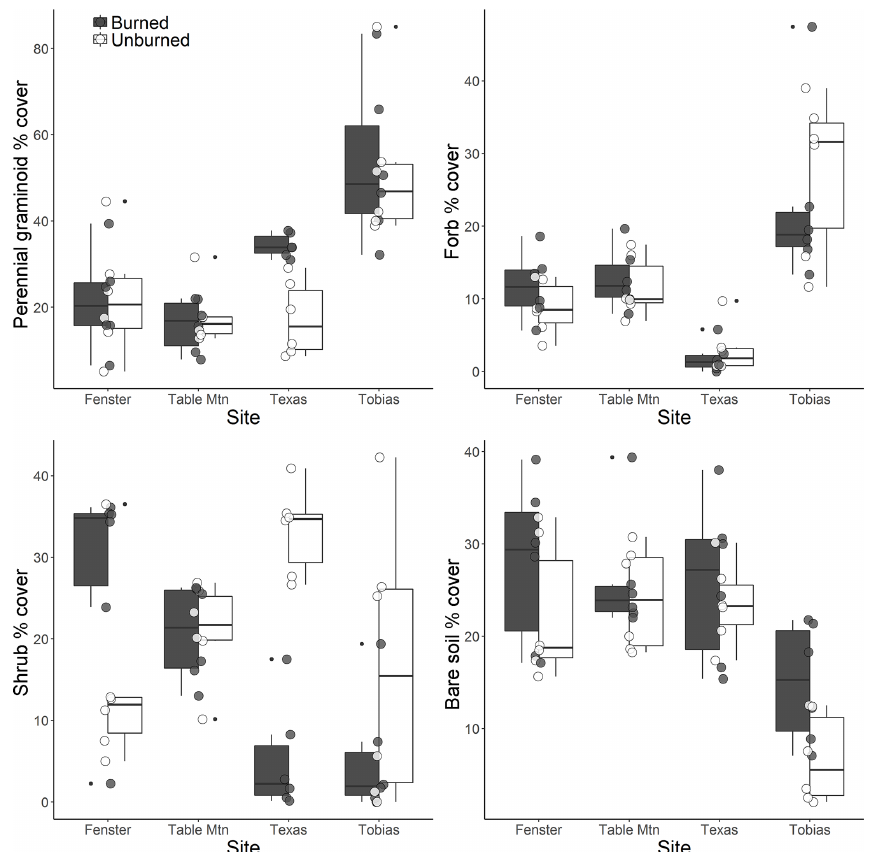
Figure 3. Vascular plant functional group cover at four sites in Idaho, USA, with symbols representing burned and unburned plots.